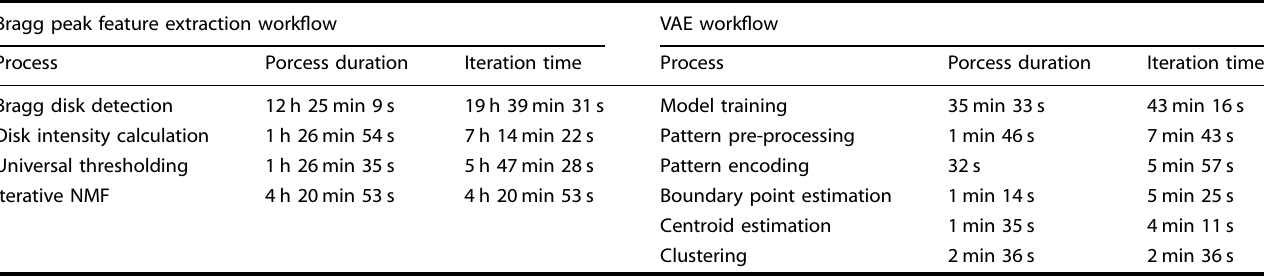
Table 1. Comparison of approximate durations of processes in Bragg peak feature extraction work fl ow with processes in the work fl ow present in this paper, on the same